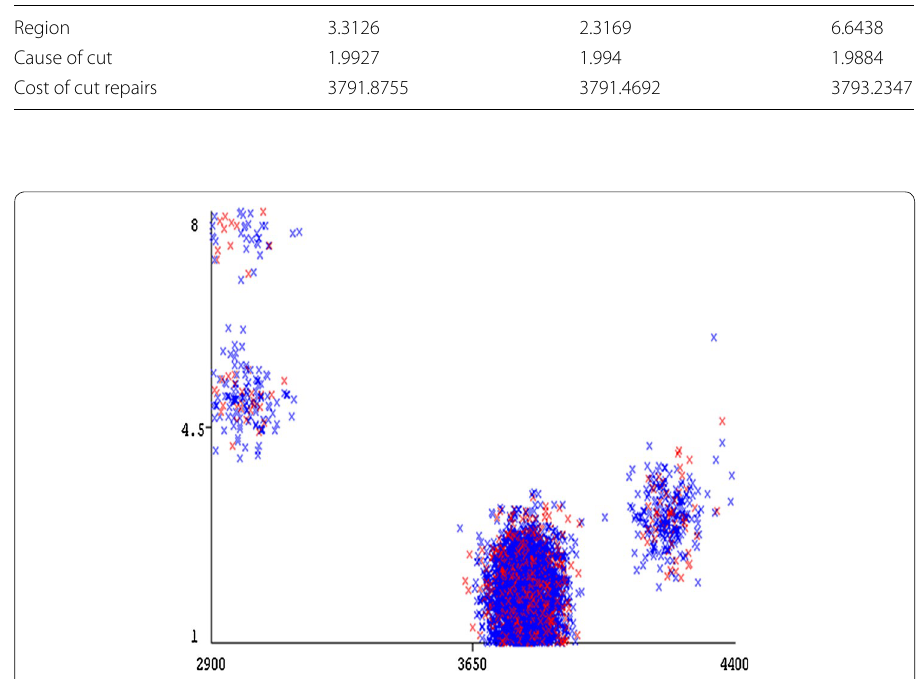
Fig. 5 K‑means Clustering